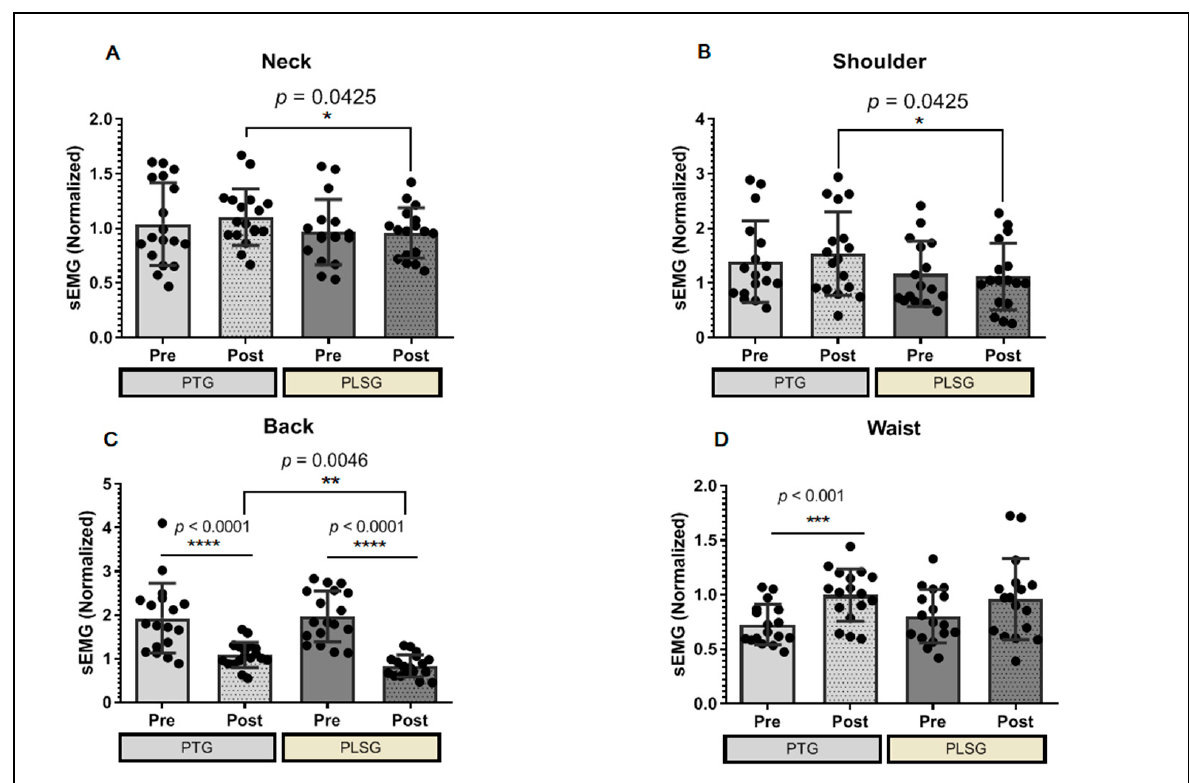
Figure 3. Changes in sEMG values for PTG and PLSG. ( A ) sEMG score at the neck, ( B ) shoulder, ( C ) back, and ( D ) waist areas of participants. Significant differences were considered statistically at * p < 0.05, ** p < 0.01, *** p < 0.001 and **** p < 0.0001. PLSG, personal low-frequency stimulation group; PTG, physical therapy group; sEMG, surface electromyography.